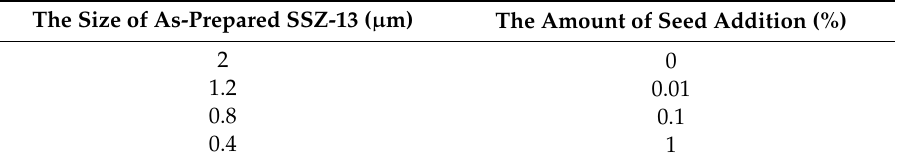
Figure 8. The SEM results of SSZ-13 with different sizes ( Si/Al = 25) . ( a ) H-0.4; ( b ) H-0.8; ( c ) H-1.2; ( d ) H-2. Synthesized gel compositions: 1 SiO 2 : 0.02 Al 2 O 3 : 0.025 Na 2 O: 0.1 SDA: 20 H 2 O. Table 4. Relationship between seed addition and the obtained particle size. Table 4. Relationship between seed addition and the obtained particle size.